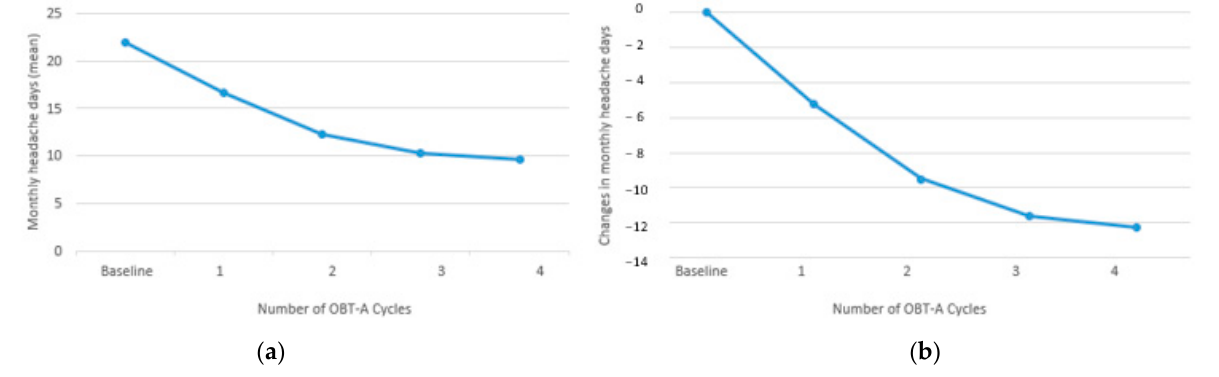
Figure 4. Changes in monthly headache days (MHDs) from baseline along with OBT-A cycles: ( a ) number of the attacks for month (mean); ( b ) difference between baseline and each cycle. increase in subjects with an average score for the intensity which can be classified as mild, while the number of severe attacks progressively decreases.